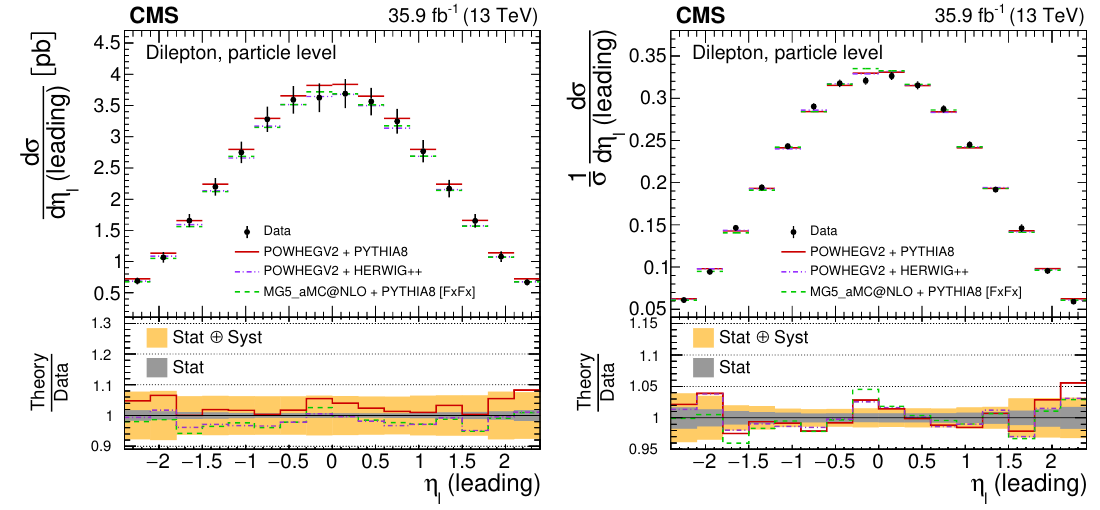
Figure 39 . The di(cid:11)erential tt production cross sections as a function of (cid:17) ‘ (leading) in a (cid:12)ducial phase space at the particle level are shown for the data (points) and the MC predictions (lines). The vertical lines on the points indicate the total uncertainty in the data. The left and right plots correspond to absolute and normalised measurements, respectively. The lower panel in each plot shows the ratios of the theoretical predictions to the data. The dark and light bands show the relative statistical and total uncertainties in the data, respectively.